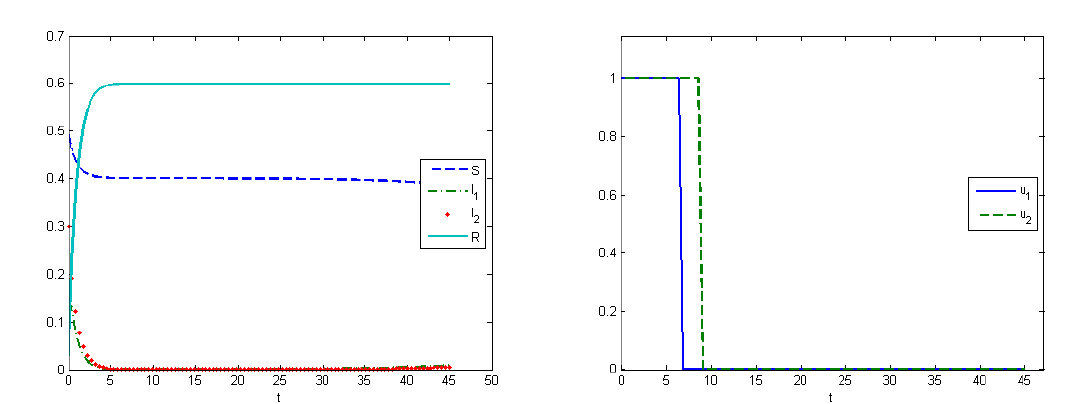
Figure 8. Experiment 4. Left : SIR model with virus mutation and application of control. Functions h i ( u i ) are concave. Vertical axis shows the fractions of the subpopulations. Right : Optimal control in SIR model with virus mutation and concave-cost functions h i ( u i ) . Control was switched off at the seventh day for V 1 , and at the ninth day for V 2 . Vertical axis shows the amount of applied control at time moment t .